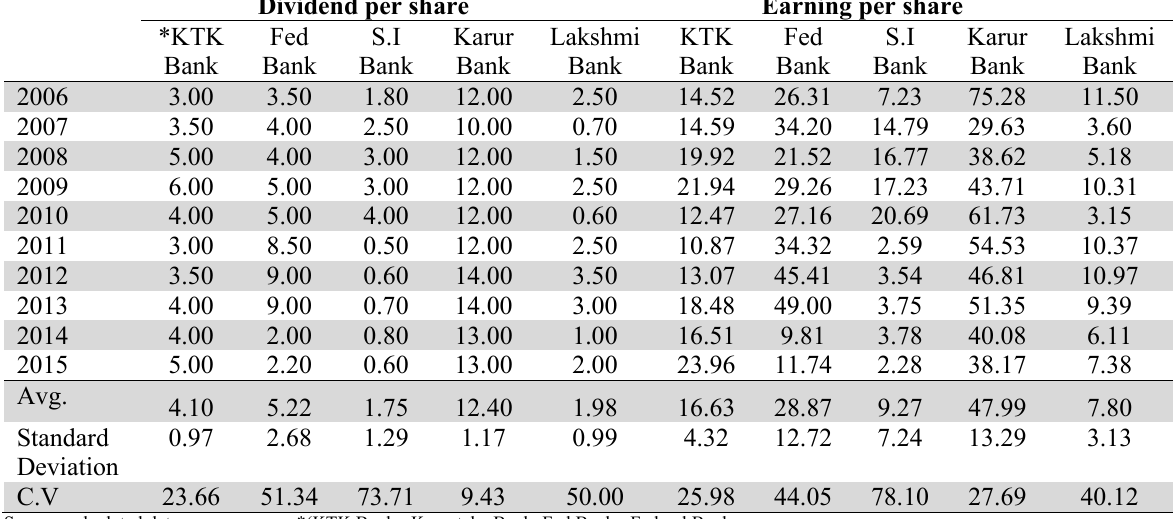
Dividend per share(DPS) and earning per share(EPS) of the selected Private Sector Banks in